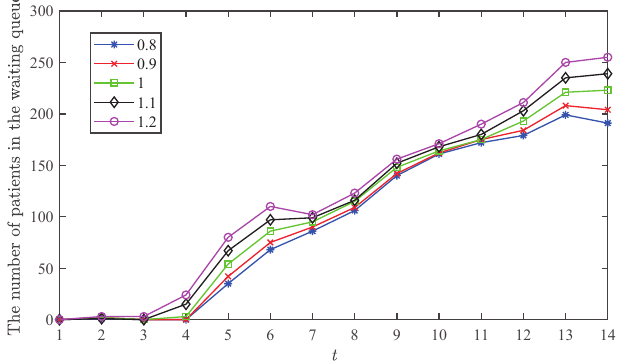
Figure 17. The number of patients in the waiting queue in case